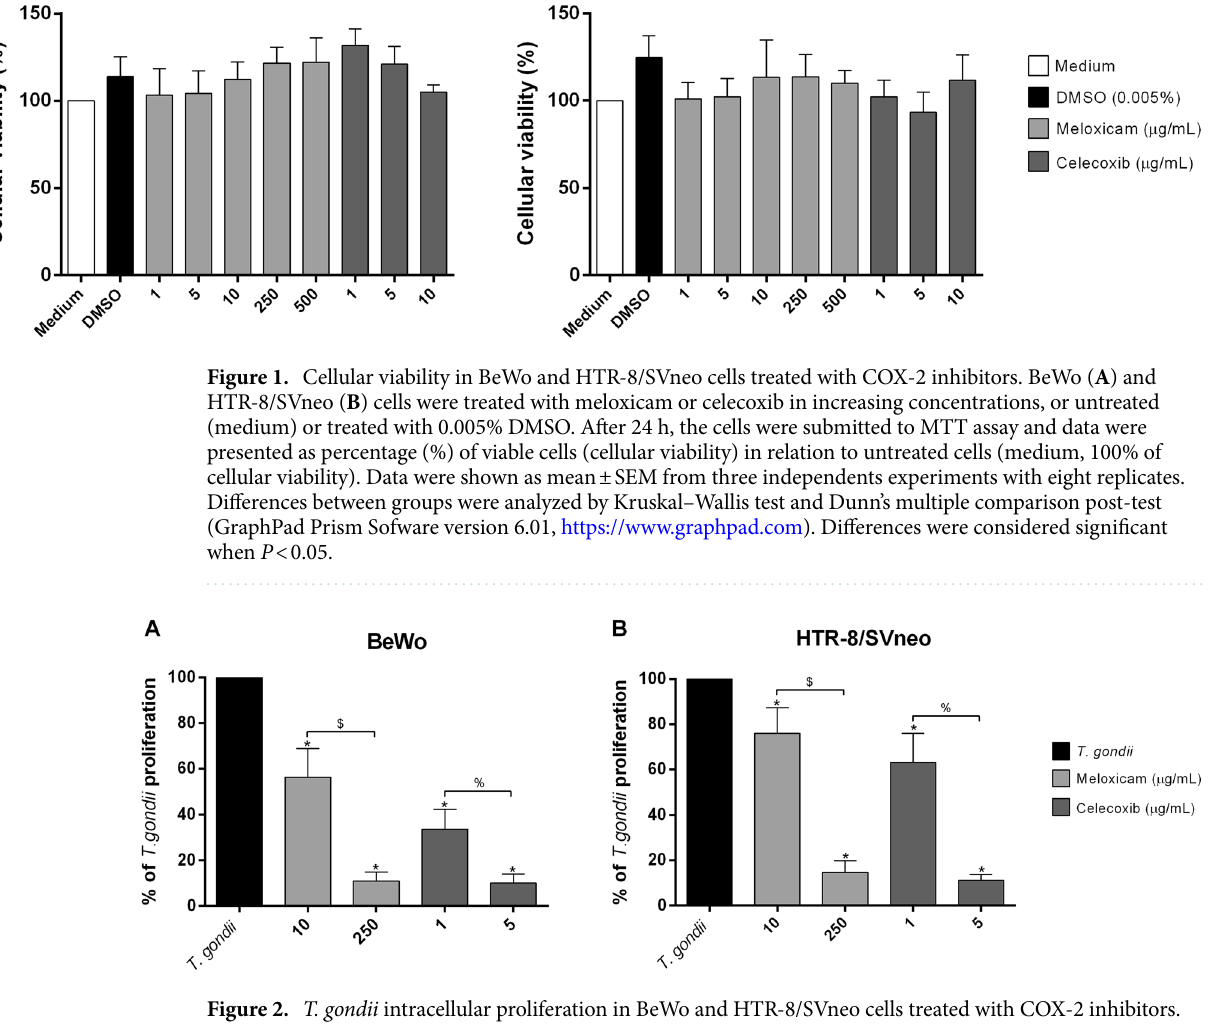
Figure 2. T. gondii intracellular proliferation in BeWo and HTR-8/SVneo cells treated with COX-2 inhibitors. BeWo ( A ) and HTR-8/SVneo ( B ) cells were infected with T. gondii for 3 h and treated or not with meloxicam or celecoxib for an additional 24 h. Next, cells were submitted to T. gondii intracellular proliferation assay (β-galactosidase assay), and data were presented as percentage (%) of T. gondii proliferation in relation to untreated and infected cells (100% of intracellular proliferation). Data were shown as mean ± SEM from three independents experiments with eight replicates. Differences between groups were analyzed by Kruskal–Wallis test and Dunn’s multiple comparison post-test (GraphPad Prism Sofware version 6.01, https:// www. graph pad. com). Significant differences in relation to untreated and infected cells ( * T. gondii ), and between concentrations of meloxicam ( $ ) or celecoxib ( % ). Differences were considered significant when P <